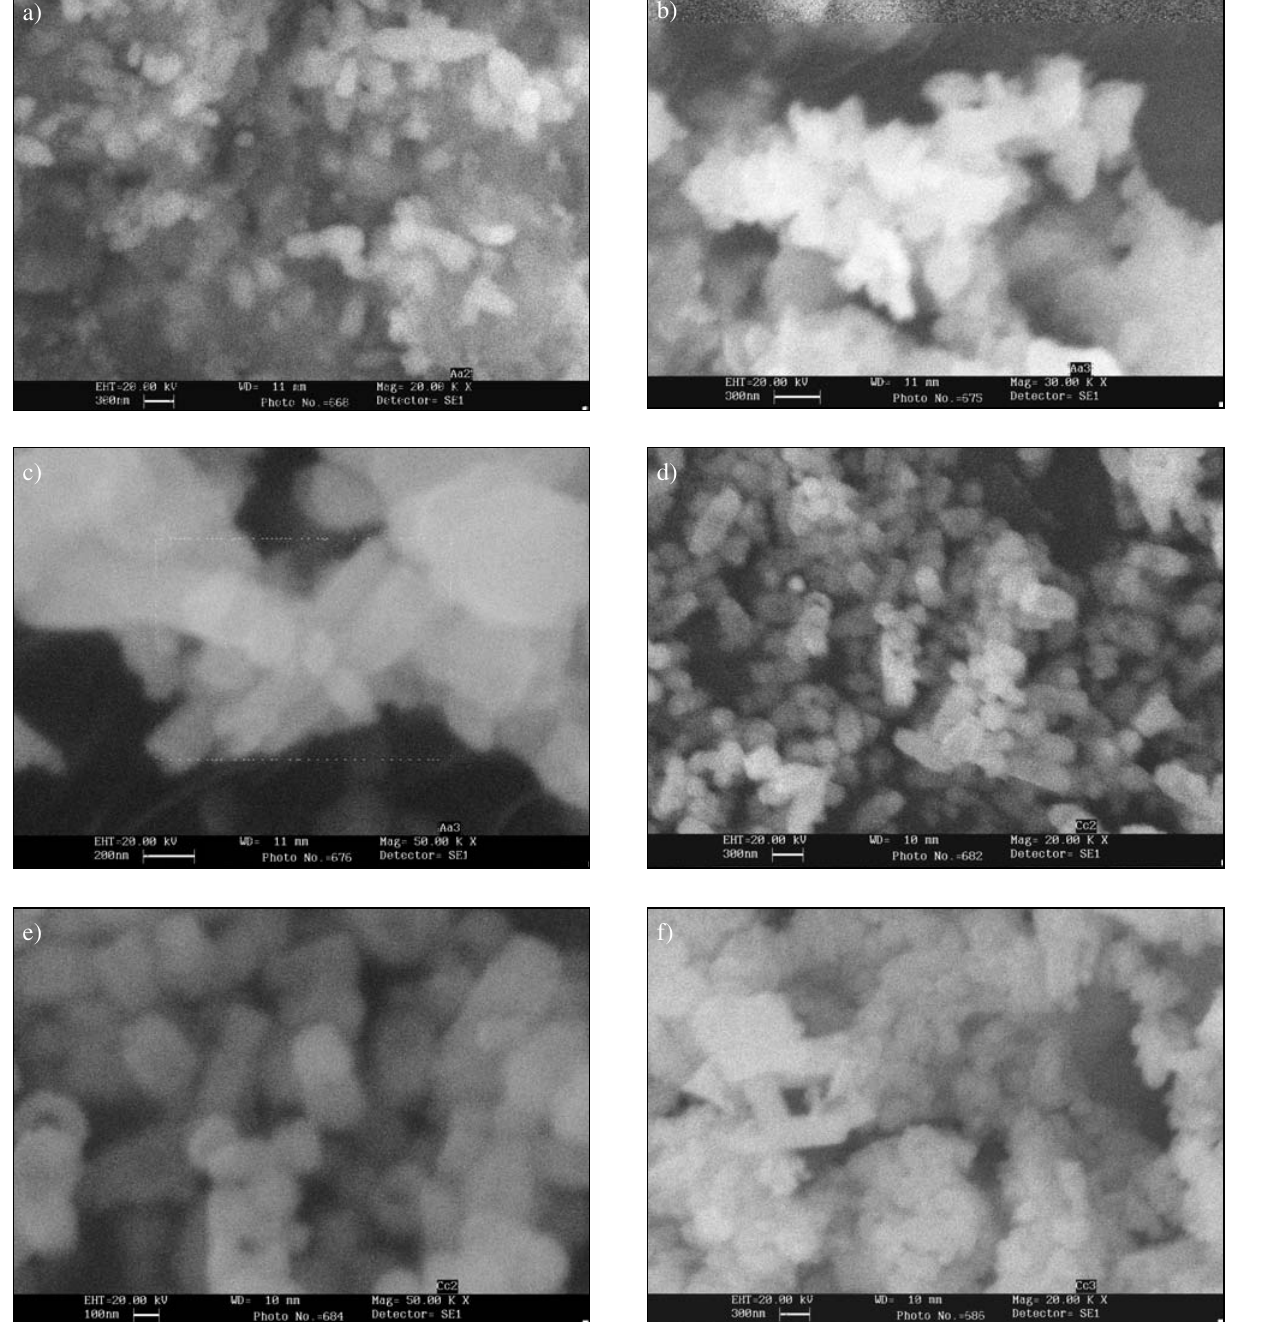
Figure 4. SEM micrographs of (a) 1.0 mol% Gd doped ZnO (CTAB) (b, c) 1.5 mol% Gd doped ZnO (CTAB) (d, e) 1.0 mol% Gd doped ZnO (PVP) (f) 1.5 mol% Gd doped ZnO